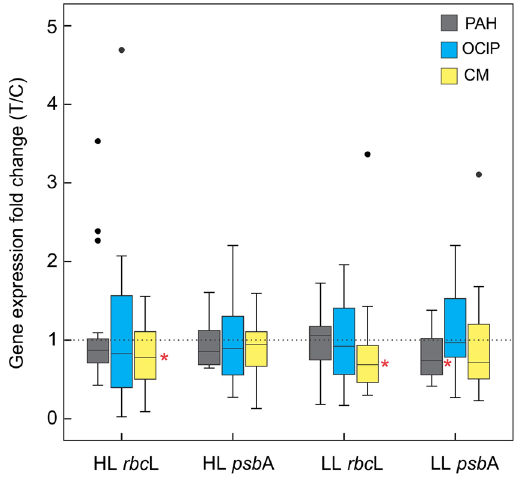
Figure 4. Distribution of gene expression changes (Treatment/Control) between the different Treated/Control samples for all treatments and incubation times. Significant differences (p-values) were calculated using paired t-tests ( * p < 0.05, indicated on the right